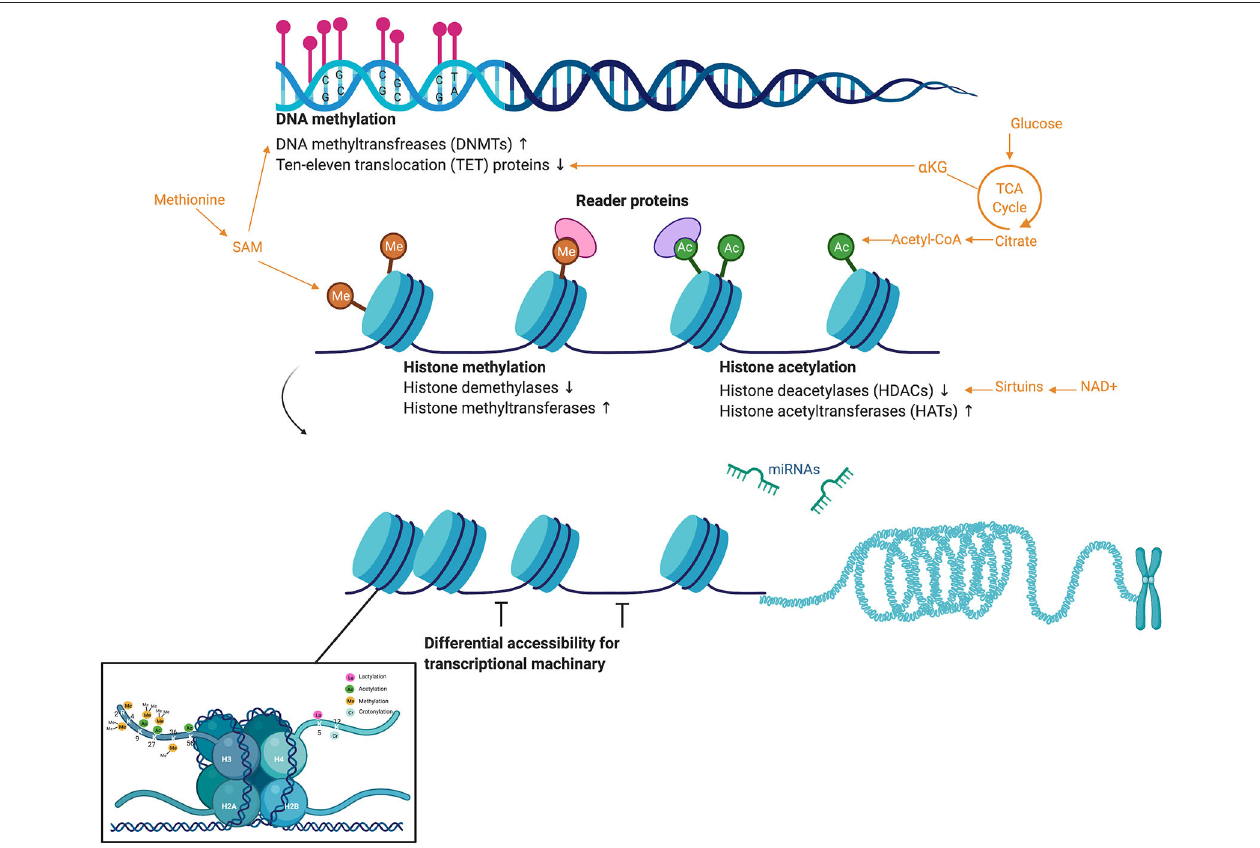
FIGURE 1 | Overview of common epigenetic modifications, the activity of chromatin modifying enzymes, and the metabolites that act as substrate. DNA methylation most commonly occurs in regions of CpG nucleotides called “CpG islands.” DNA methylation is moderated by the chromatin modifying enzymes DNA methyltransferases (DNMTs), which deposit methylation marks and use methionine metabolism as a substrate, and ten–eleven translocation (TET) proteins, which mediate demethylation and use the TCA cycle intermediate alpha-ketoglutarate as a substrate. Once DNA is wound around histone proteins, chromatin modifying enzymes regulate a suite of histone modifications such as methylation (again using methionine metabolism) and acetylation (using acetyl-CoA). Sirtuins, a family of signaling proteins often involved in metabolic regulation, can act as NAD + dependent deacetylases of both histones and non-histone proteins. While microRNAs are not considered canonical epigenetic modifications, they can affect the chromatin modifying enzymes depositing epigenetic marks, as well as recruit protein complexes that alter chromatin structure. These epigenetic marks and microRNAs affect differential accessibility of chromatin for transcriptional machinery. This figure created with